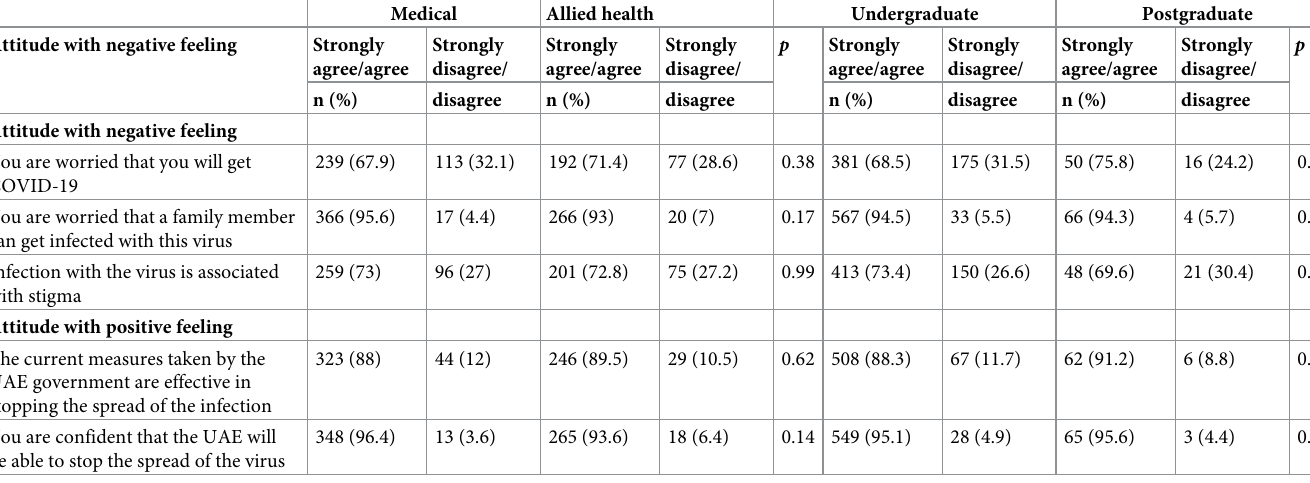
Table 5. Responses to the survey on COVID-19 attitude comparing medical students with allied health students and undergraduate with postgraduate